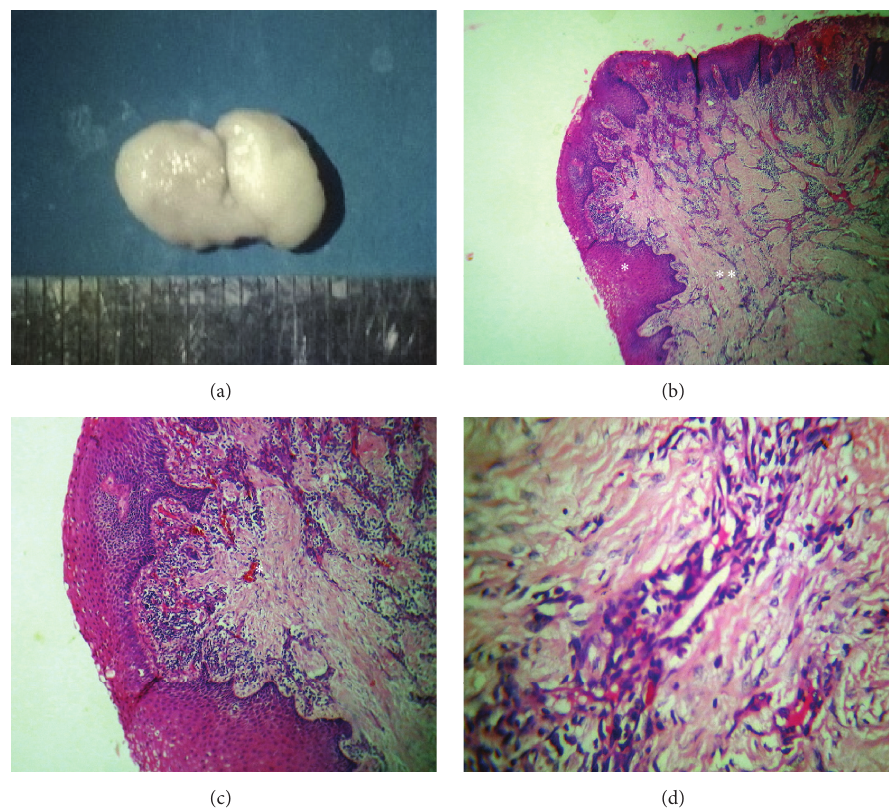
Figure 4: Case 4 description: (a) gross specimen; (b) scanning view showing hyperplastic parakeratinized stratified squamous epithelium ( ∗ ) and connective tissue with numerous endothelial cell lined capillaries and dense fibrous stroma ( ∗∗ ) (H&E, 50x); (c) low power view: stroma showing numerous proliferating endothelial cell lined capillaries ( ∗ ) (H&E, 100x); (d) high power view showing fibrosis around capillaries (H&E, 400x).